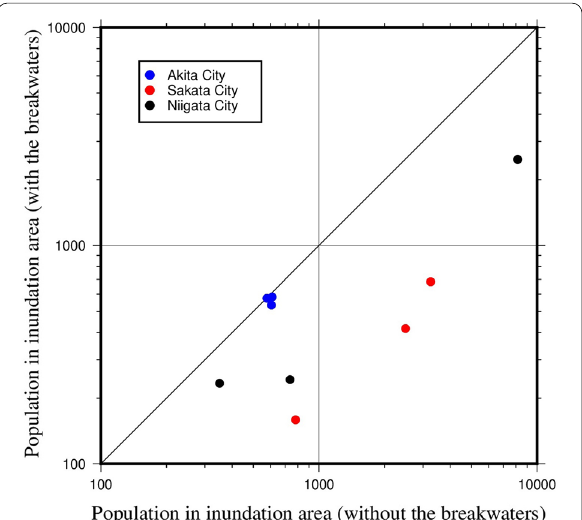
Fig. 12 Comparison of the total population within the inundation area in the scenarios with and without the